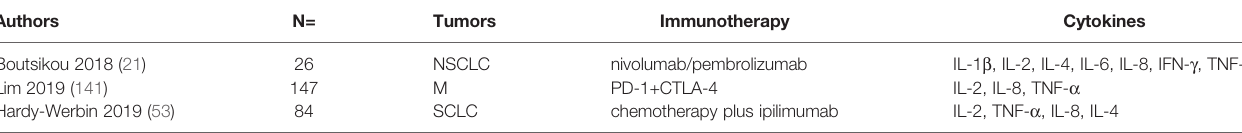
TABLE 3 | Clinical studies of the association of ICT response with other cytokines.